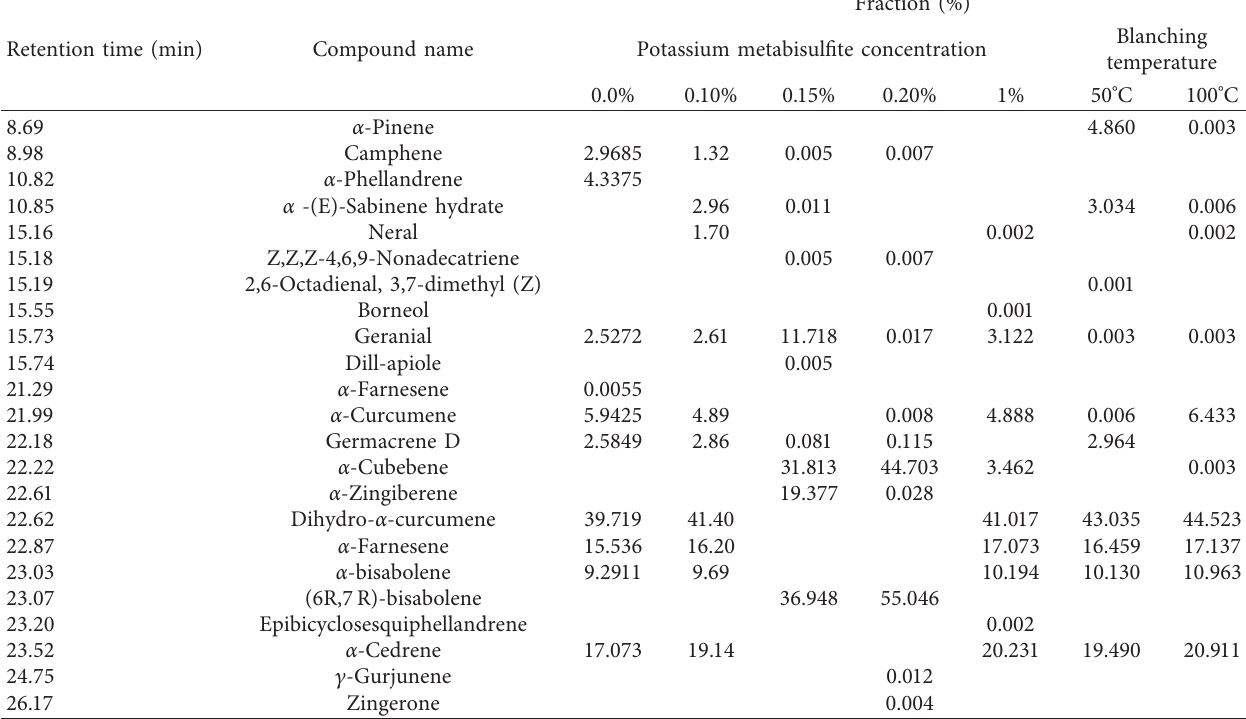
Table 2: Major volatile compounds detected in pretreated sliced solar dried yellow ginger